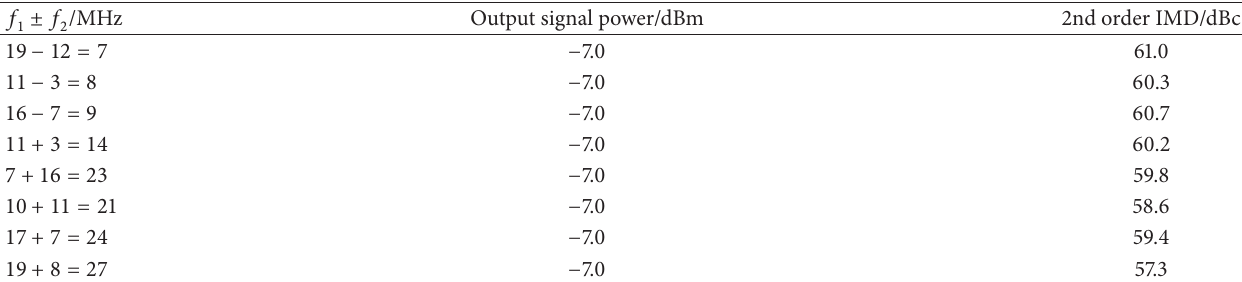
Table 1: Second order IMD result.